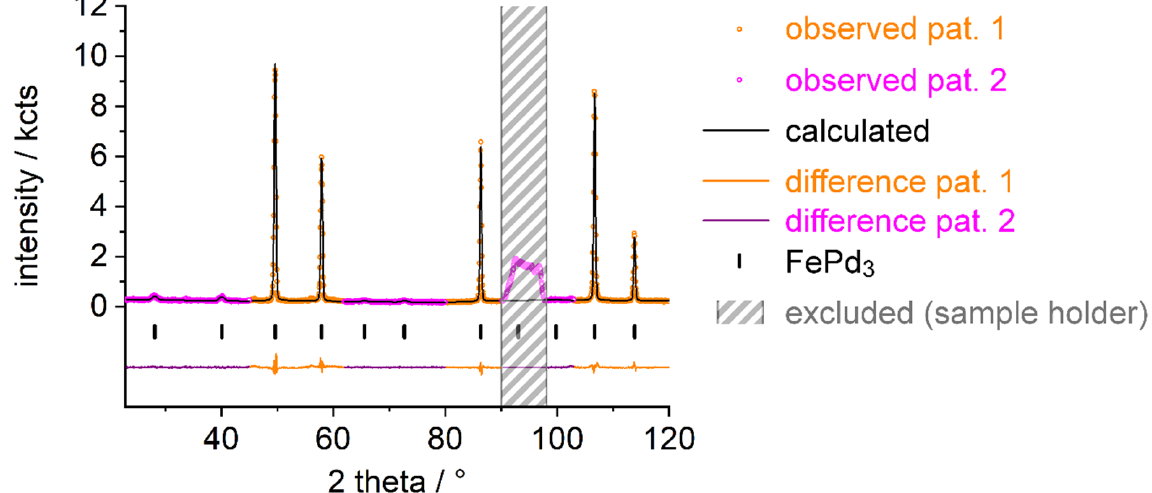
Figure A25. Rietveld refinement of the crystal structure of FePd 3 D 0.052(9) (for details, see thirteenth row in Tables A8 and A9) based on neutron powder diffraction data (NUMOR 131847 [21], λ =186.80(2) pm, D20 ILL, Grenoble) in a single-crystal sapphire cell at 423(2) K and 8.20(1 ) MPa deuterium pressure using FullProf [24].